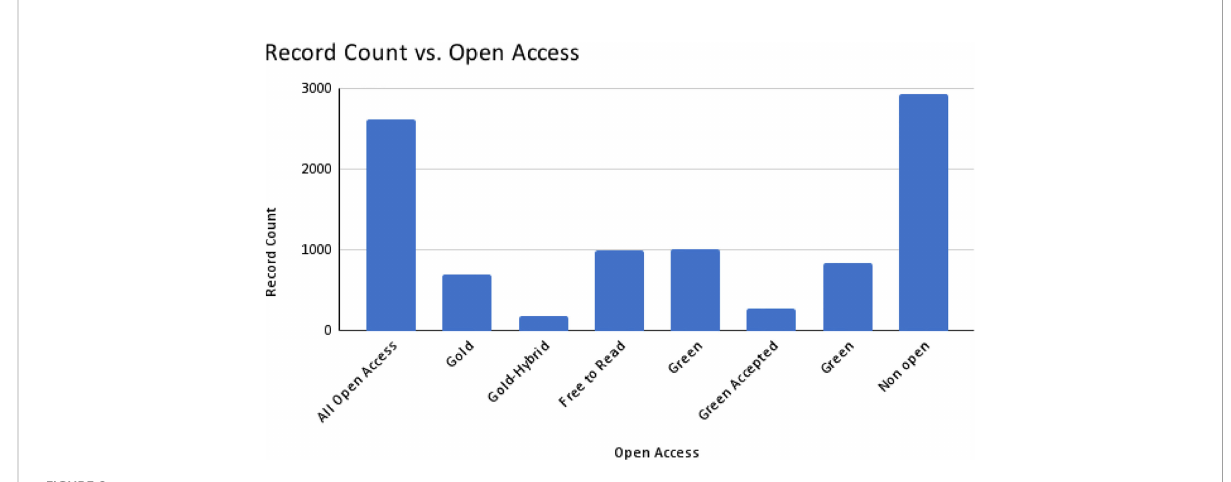
FIGURE 2 Level of open access of the generated lobster literature in the WOSCC